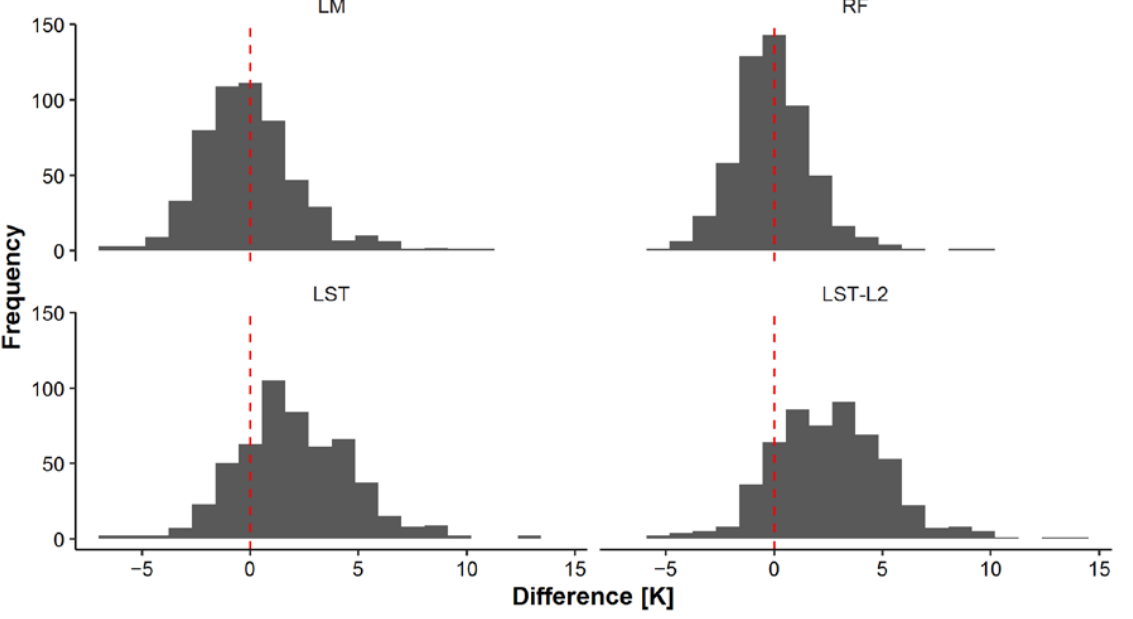
Figure 6. Differences between measured water temperatures and water temperatures estimated by models. The red dashed line marks the error equal to 0